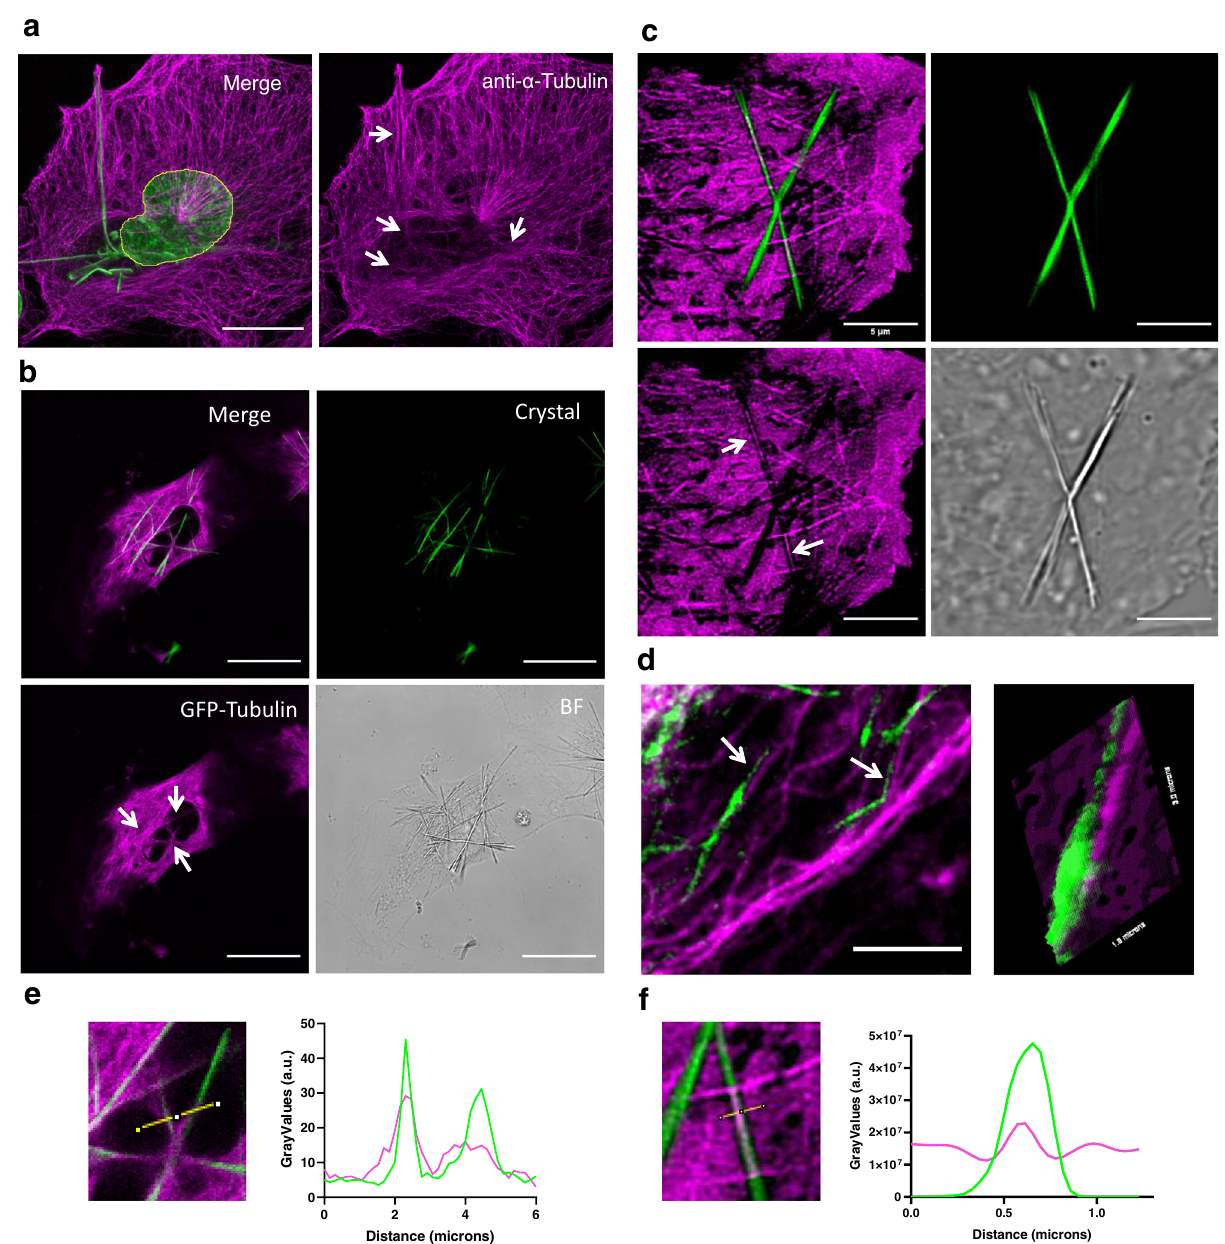
Fig. 2 QPD-OTf forms crystals that strongly co-localize with MTs in cells. a Tubulin immunostaining in fi xed U2OS treated with QPD-OTf (20 µ M; 4 h); white arrows indicate colocalization with crystals (anti- α -tubulin: magenta; crystal and DAPI: green; the nucleus is contoured in yellow). Scale bar 20 µ M. b Live-cell imaging of PTK2-GFP-Tubulin treated with QPD-OTf (20 µ M; 2 h); white arrows indicate colocalization with crystals (GFP-tubulin: magenta; crystal: green). Scale bar 20 µ M. c Super-resolution imaging of HeLa-GFP-Tubulin live cells treated with QPD-OTf (20 µ M; 2 h); white arrows indicate colocalization with crystals (GFP-tubulin: magenta; crystal: green). Scale bar 5 µ M. d Super-resolution image of live HeLa-GTP-Tubulin cells treated with QPD-OTf at an early time point (QPD-OTf 20 µ M; 20 min) (left); white arrows indicate colocalization with crystals; scale bar 5 µ M. Surface plot of crystal and MT signal (right) (GFP-tubulin: magenta; crystal: green); surface section: 1.8 × 3.0 microns. e , f Plot pro fi les of tubulin channel (magenta) and QPD channel (green). Yellow lines represent the sections plotted in the graphs; (a.u. represent arbitrary units). Source data are provided as Source Data fi